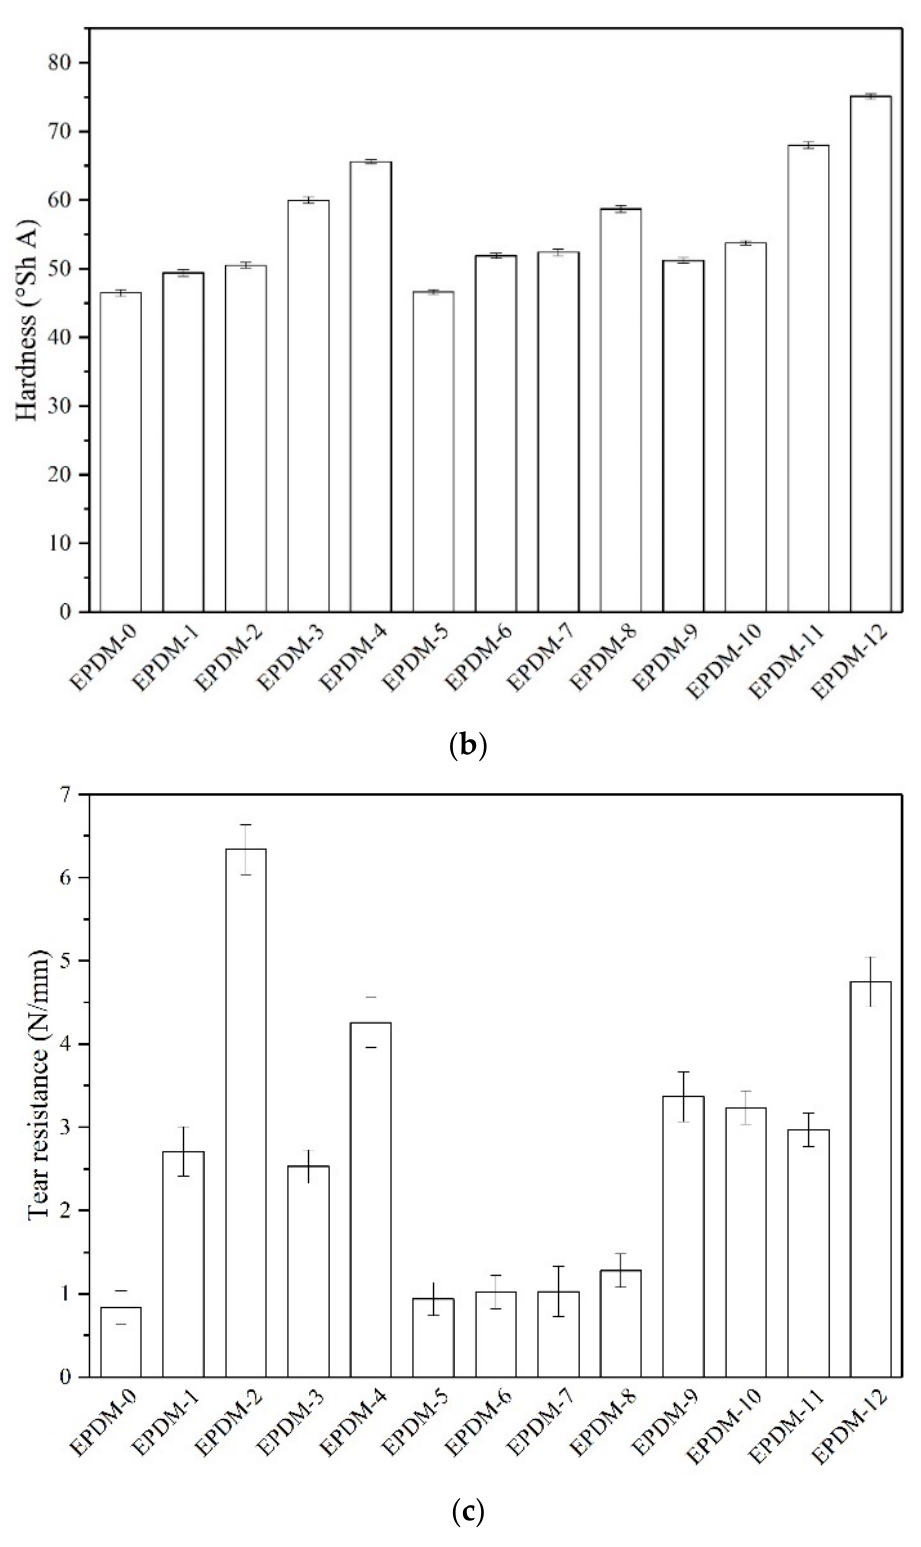
Figure 8. Mechanical performance of the EPDM composites: ( a ) tensile properties; ( b ) hardness; ( c ) tear resistance.